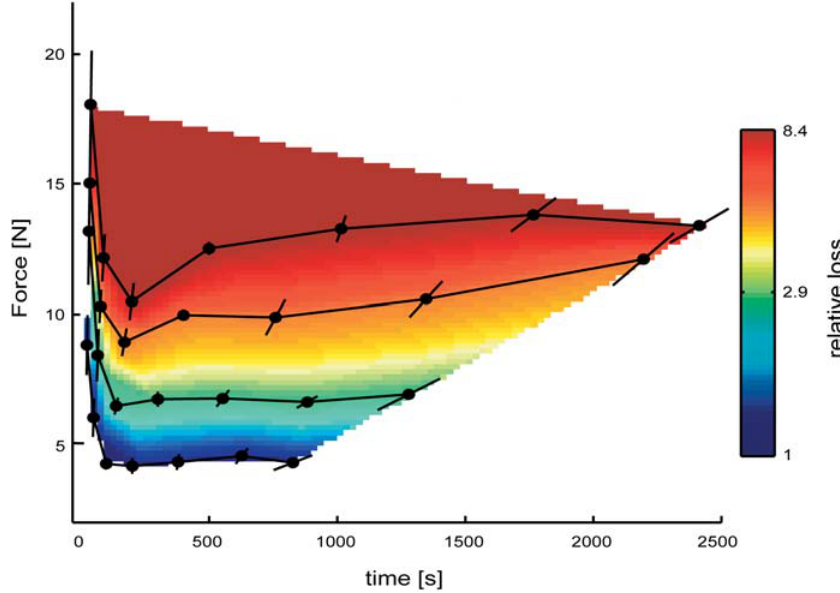
Figure 3. Iso-Loss Contours and Loss Function for the Set of All Subjects The black curves are the iso-loss curves. Error bars denote the standard error of the mean over the population. The color plot represents the inferred loss function (warmer colors represent greater loss) obtained by interpolating the data from the double-hump forces. DOI: